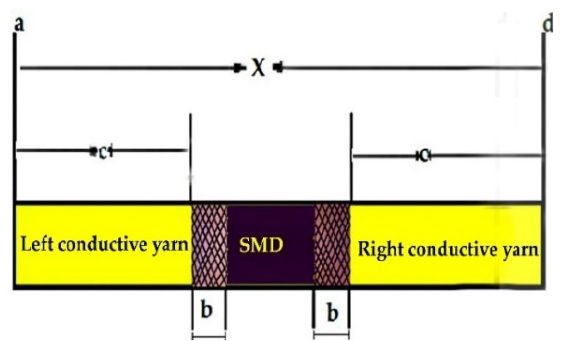
Figure 7. Sketch illustration of calculation of resistance ratio.